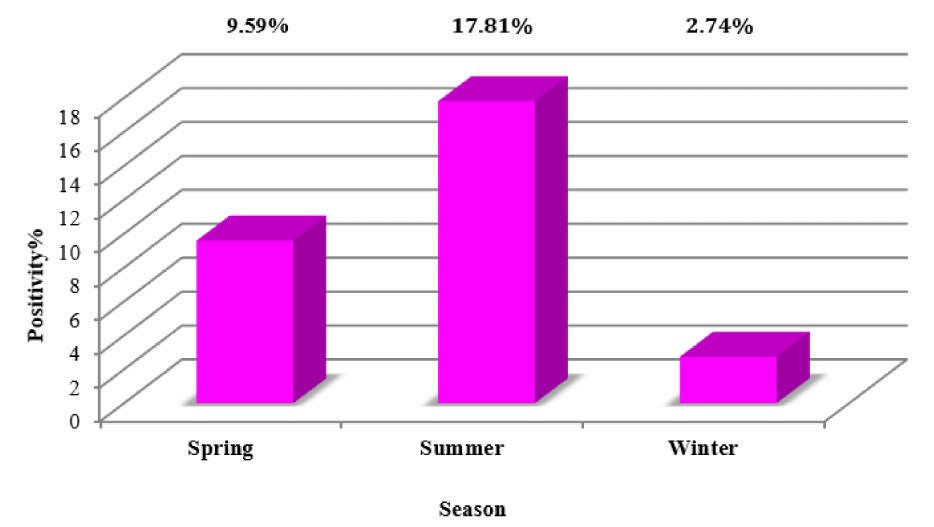
Figure 6. Distribution of MELISA-positive BTMs in three di ff erent seasons: spring (9.59%), summer (17.81%), and winter